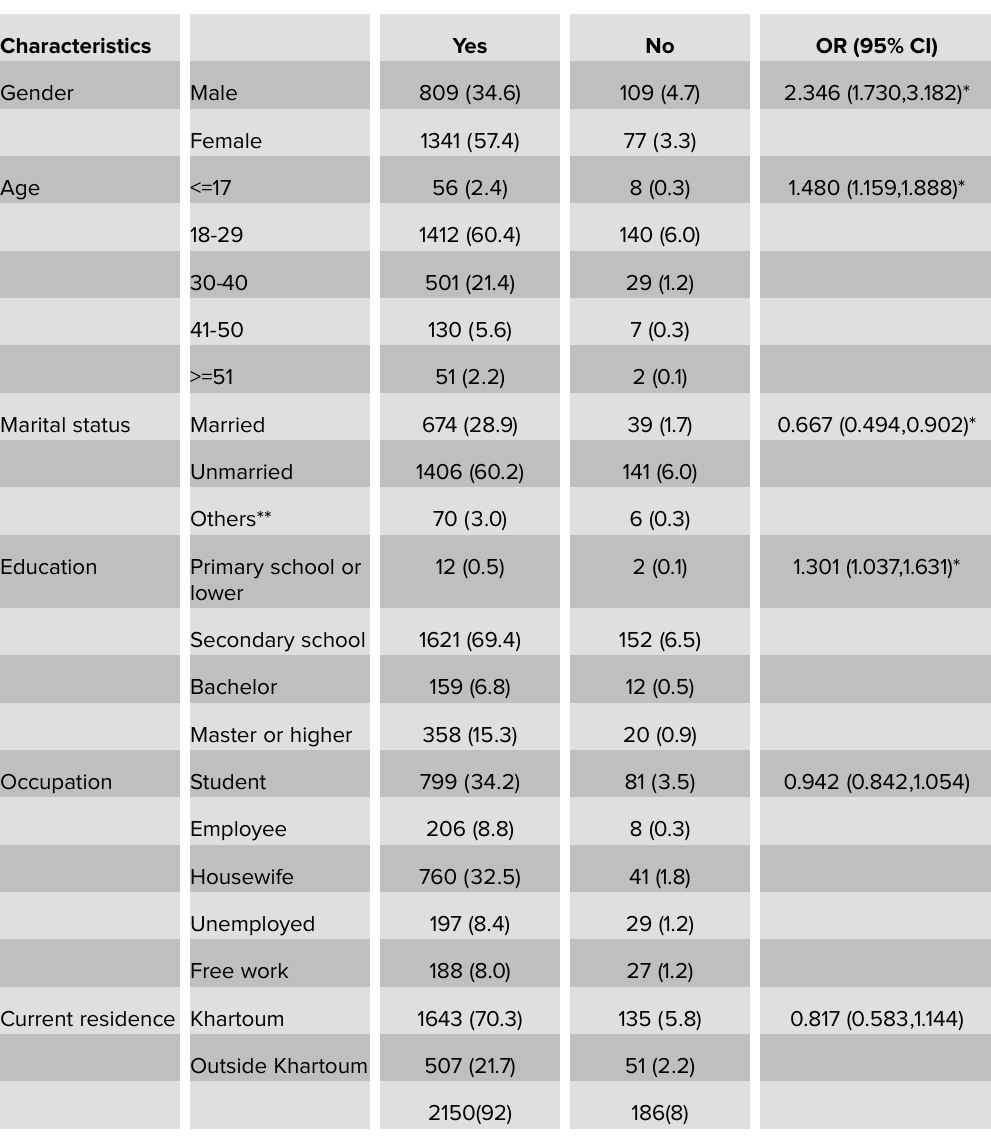
TABLE 9: Practices towards COVID-19 by demographic variables, (Do you wash your hands frequently or using the antiseptic before touching your face?)